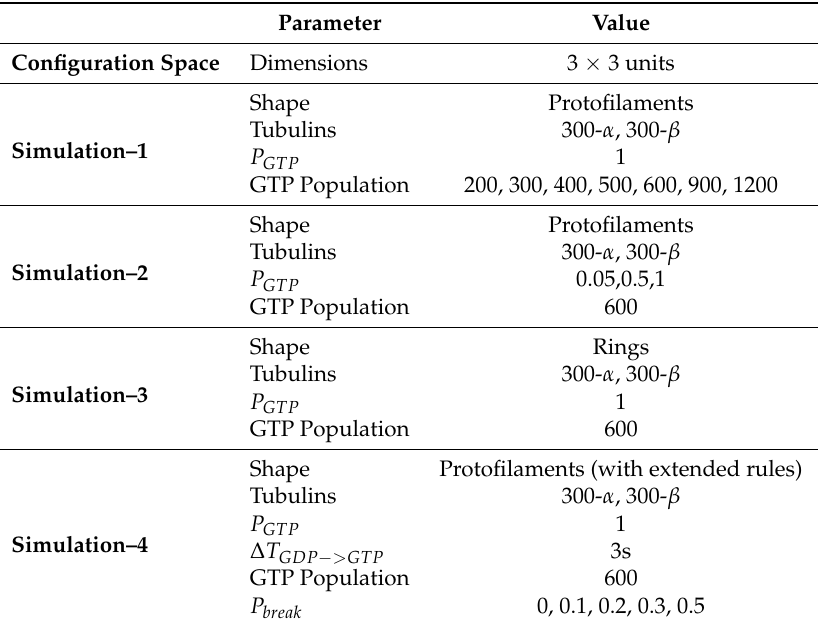
Table 2. Simulation and Parameter Combination